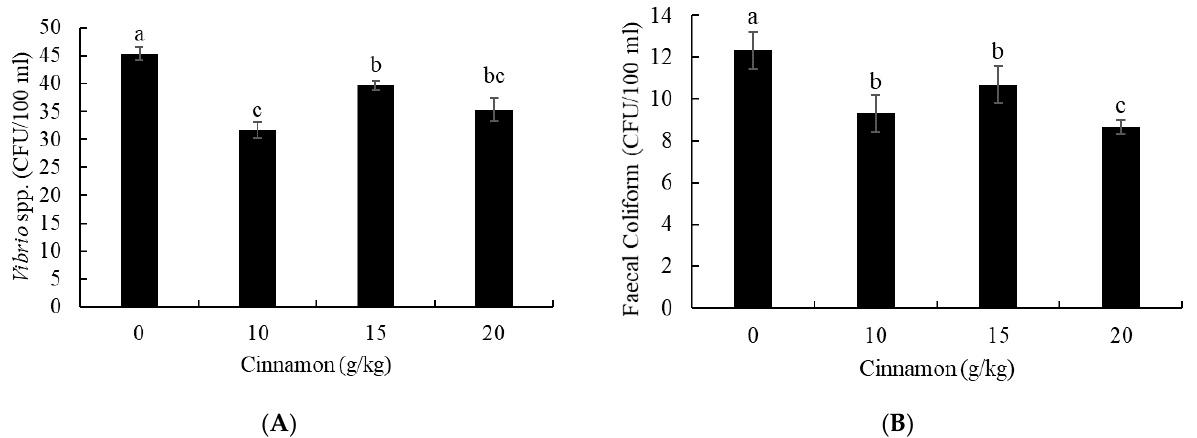
Figure 2. Intestinal harmful bacterial count: ( A ) Vibrio spp. and ( B ) Faecal Coliform of European seabass fed dietary cinnamon. Bars with different letters are significantly different ( p < 0.05).